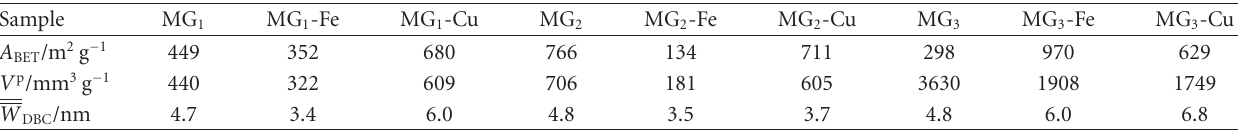
Table 1: Textural properties of porous